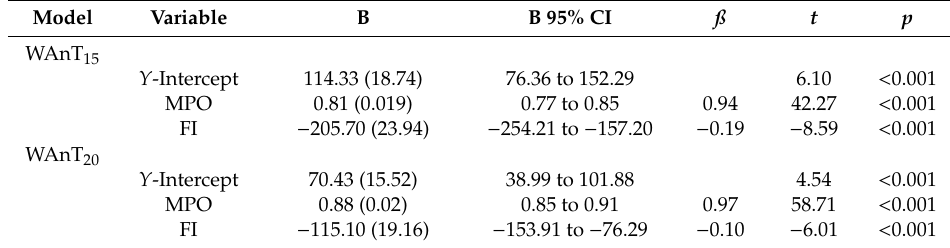
Table 1. Regression models to estimate 30 s mean power output (MPO) using the MPO and the fatigue index (FI) obtained in the first 15 (WAnT 15 ) and 20 (WAnT 20 ) seconds of the test. Model Variable B B 95% CI